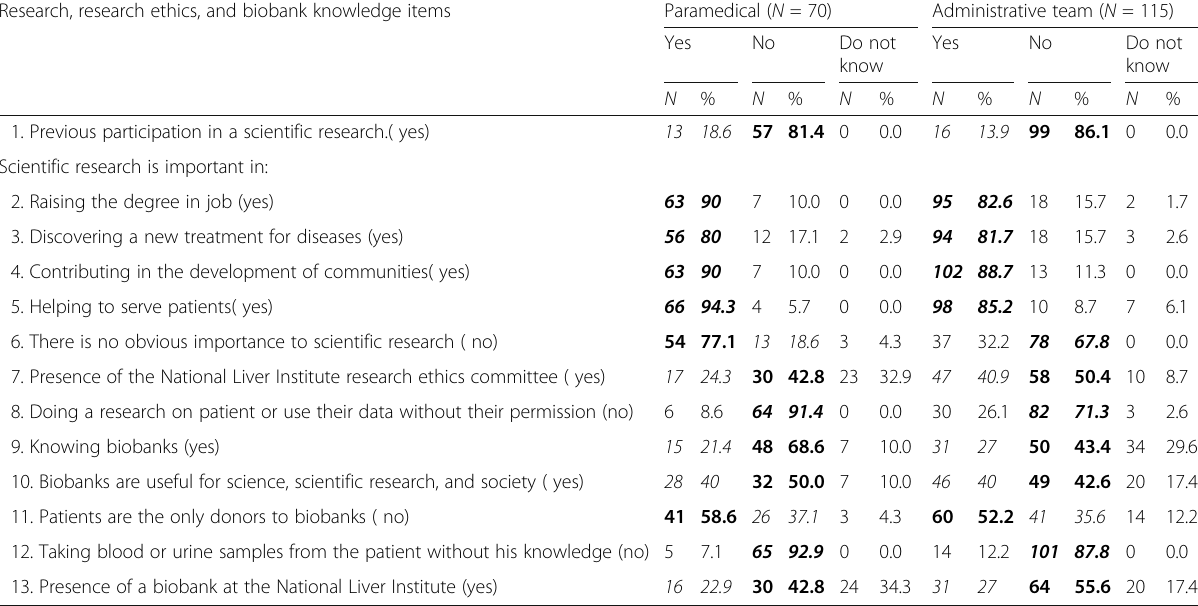
Table 2 Research, related ethics, and biobank knowledge of the studied paramedical and administrative team participants, pre- intervention